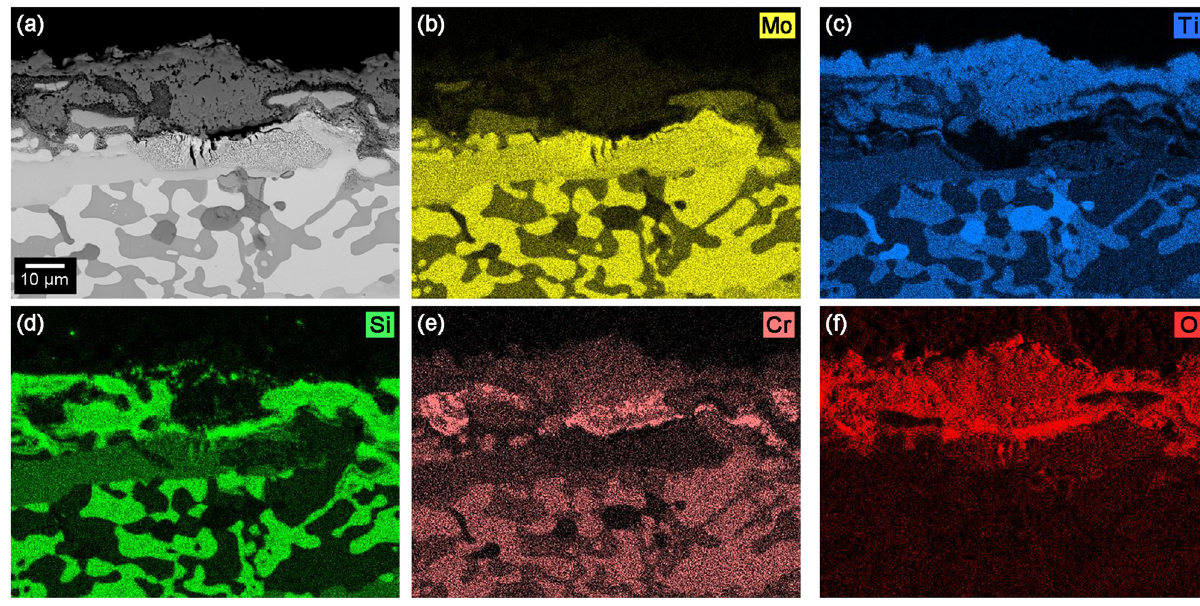
Figure 10: ( a ) Cross - section BSE image and ( b ) – ( f ) the corresponding EDX elemental maps of the 10Cr alloy oxidized at 1,100°C for 12